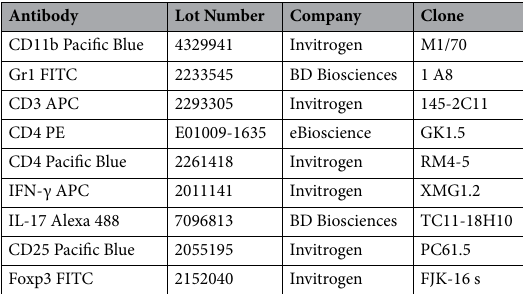
Table 1. Antibodies used in the experiments.